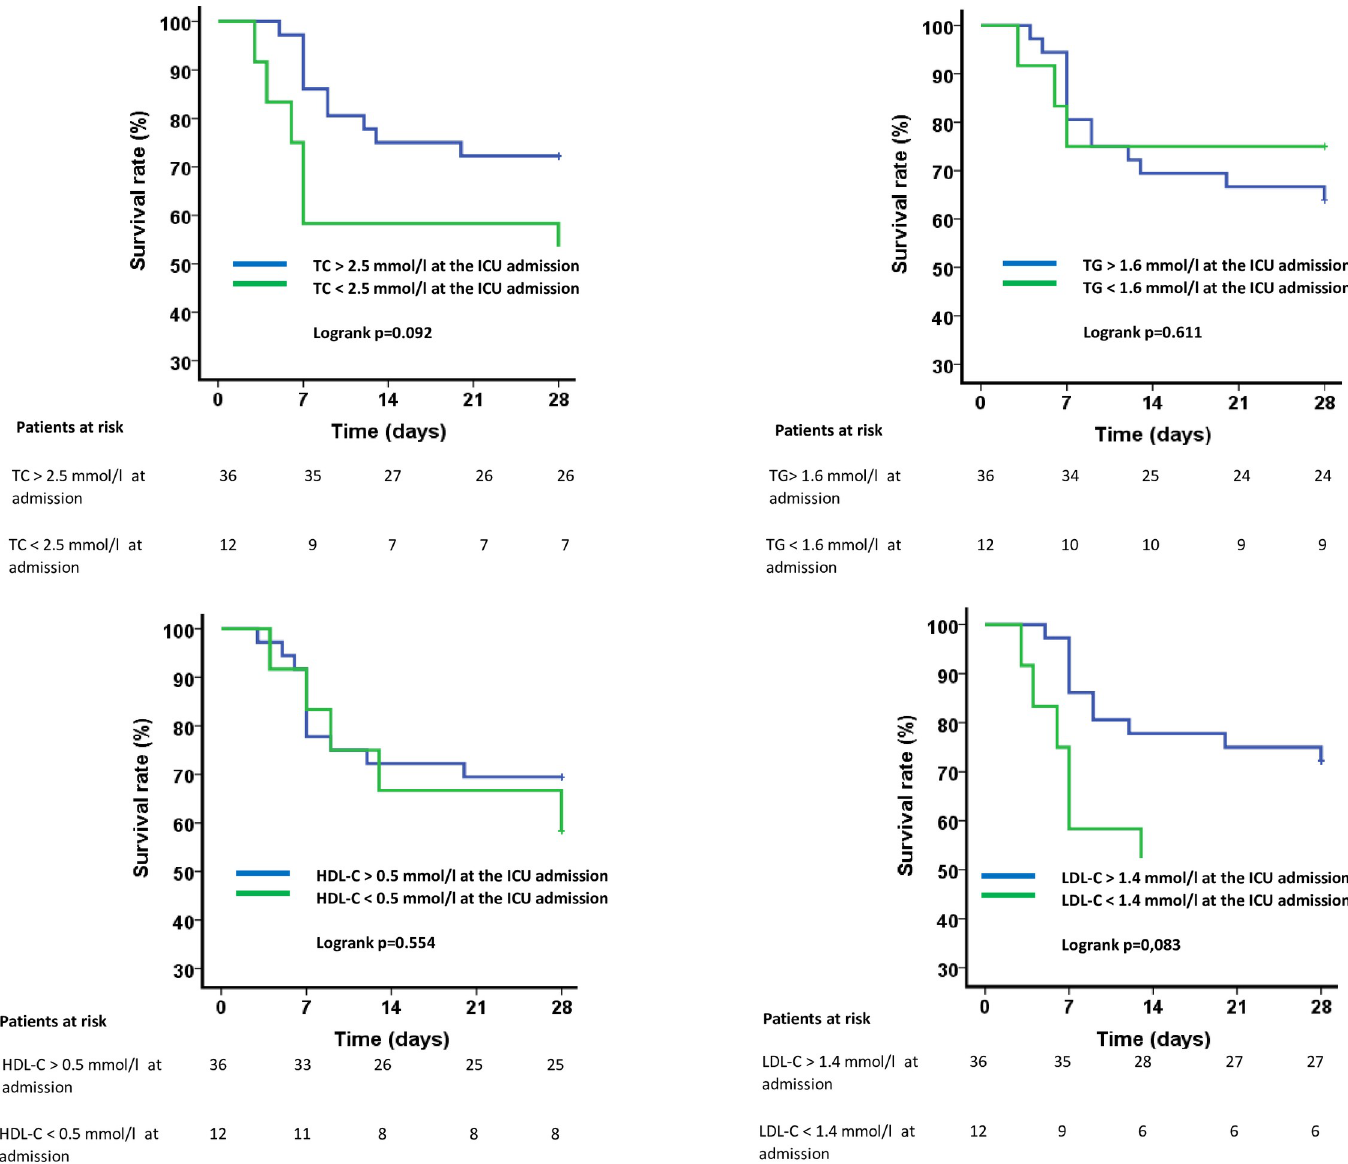
Fig 3. Mortality at day 28 according to the lipid profile upon ICU admission. Survival analyses were estimated by Kaplan-Meier analysis and compared using the log- rank test.